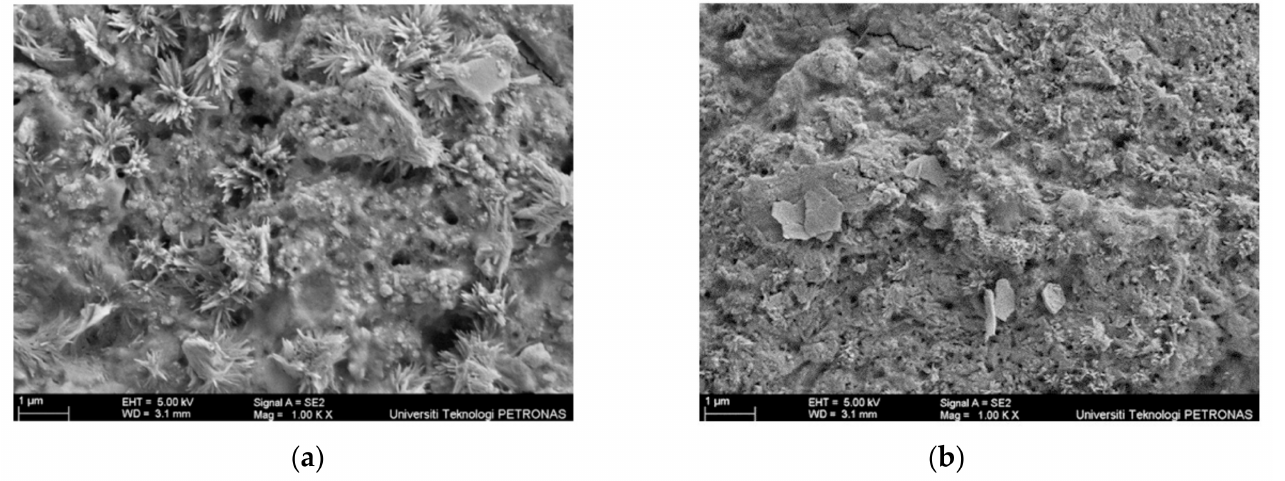
Figure 8. Coating surface sample before the fire test: ( a ) S26 and ( b )